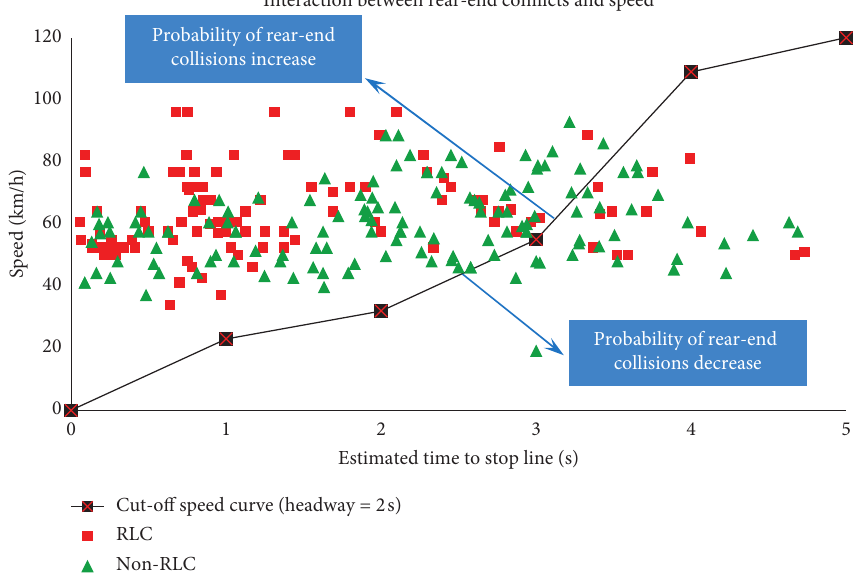
Figure 8: The rear-end collision probability distribution with